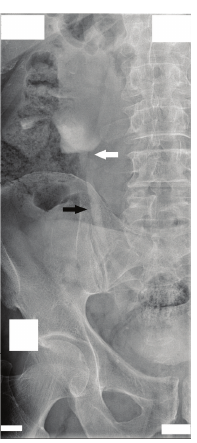
Figure 8: Intravenous urography 5 months after the last procedure shows chronically enlarged renal pelvis and a strong jet of contrast medium through the ureteropelvic junction (white arrow) and proximal and middle ureter (black